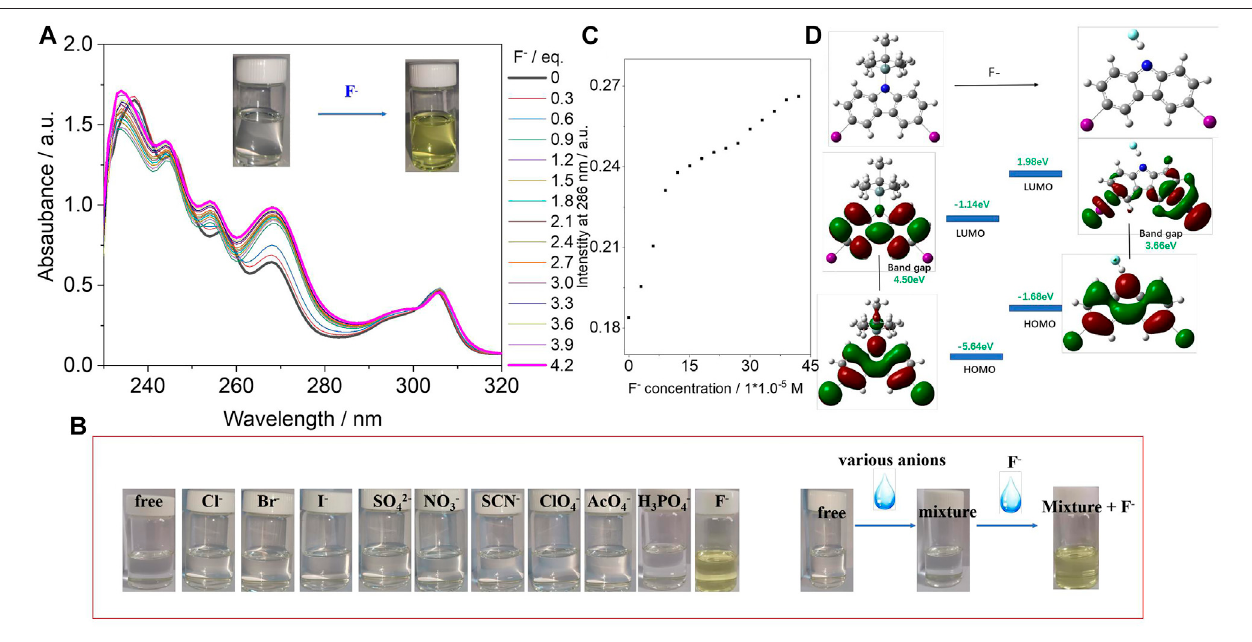
FIGURE 1 | (A) UV/vis absorption spectra of CA-TBMDS (1.0 × 10 – 4 M) in the presence of F − (0 – 4.2 eq.) in THF. Inset shows photograph of CA-TBMDS solution with or without adding different amounts of fl uoride anion under ambient light. (B) Photographs of CA-TBMDS (5 × 10 − 5 M) in THF before and after adding different anions, as well the addition of other anions together with and without F − . (C) Optical absorption intensity at 286 nm against the concentration of fl uoride anion. (D) Molecular orbital surfaces of the HOMO and LUMO energy levels of CA-TBMDS at the B3LYP/6 – 31G (d, p) level, before and after adding fl uoride anion.